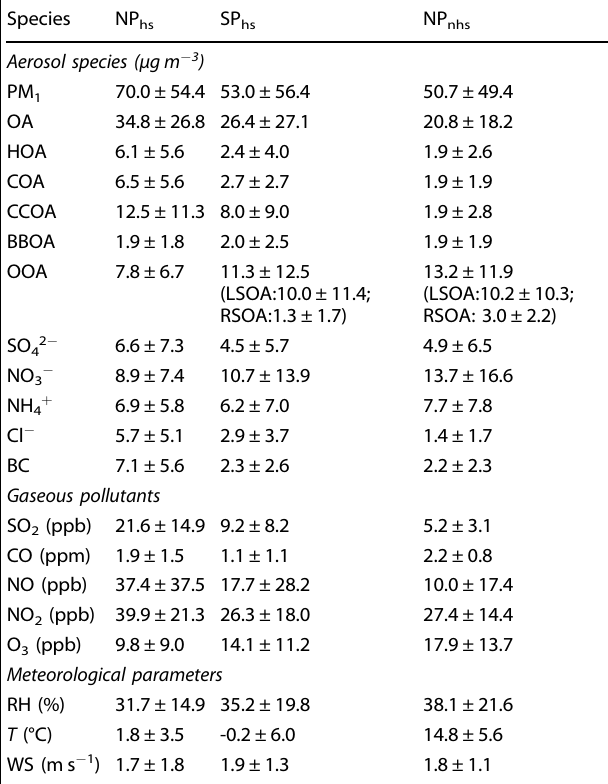
Fig. 2 Comparisons of PM 1 species between deweathered and observed results. a Mass concentrations and b fractions of deweathered and observed PM 1 species during the NP hs , SP hs , and NP nhs . The observed and deweathered change ratios of PM 1 species between c NP hs and SP hs , d SP hs and NP nhs (the bars below the horizontal line represent increased ratios, and the bars above the horizontal line represent decreased ratios of PM species). Table 1. Observed mass concentrations (averages + standard deviations) of aerosol species and OA factors, gaseous pollutants, and meteorological parameters during three different